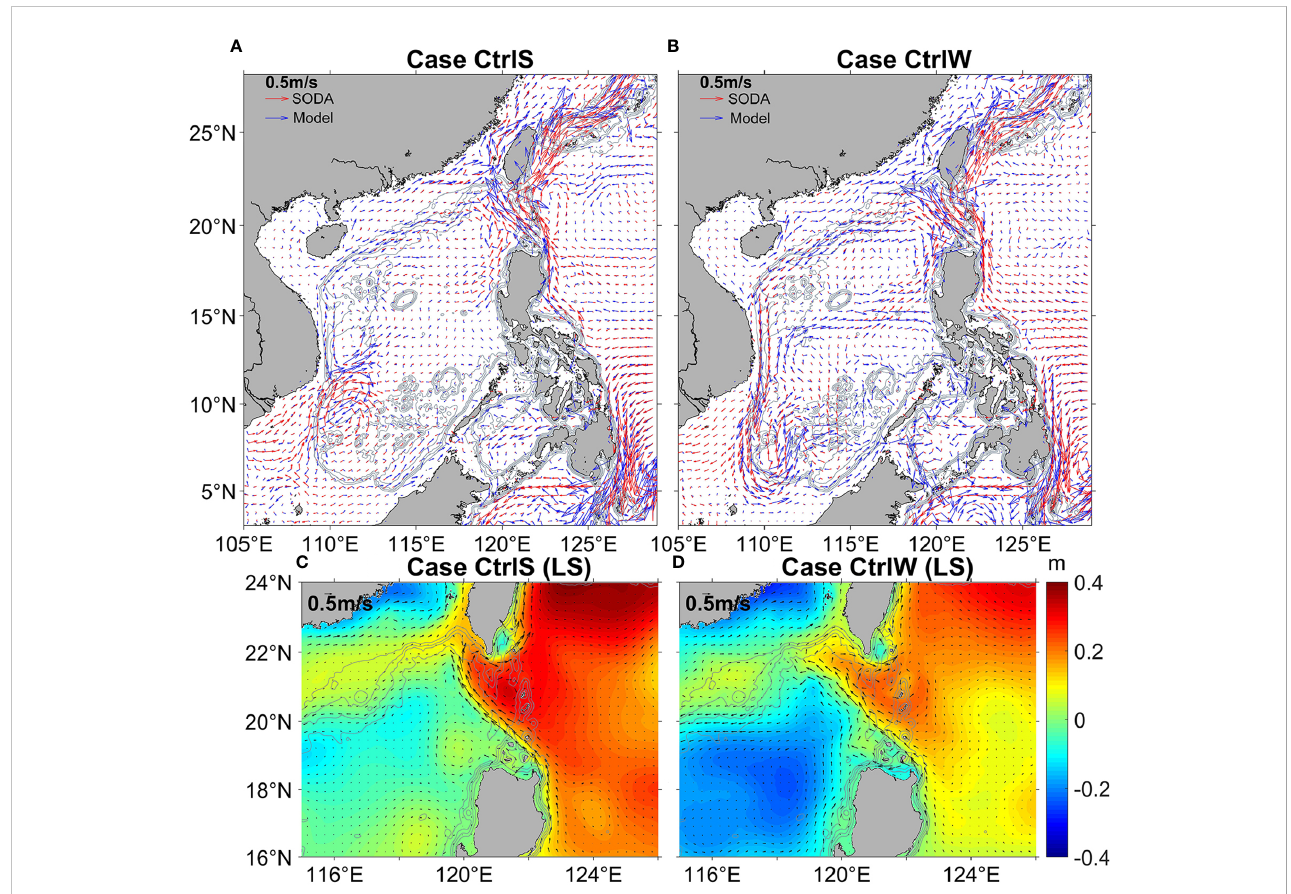
FIGURE 2 Mean fl ow vectors from the simulations and from the SODA (simple ocean data assimilation) reanalysis data. (A) Summer case CtrlS (blue), SODA (red). (B) Winter case CtrlW (blue), SODA (red). (C, D) show the mean velocity vector averaged over the upper 100 m and the sea surface height (color, m) from cases (C) CtrlS and (D) CtrlW in the LS